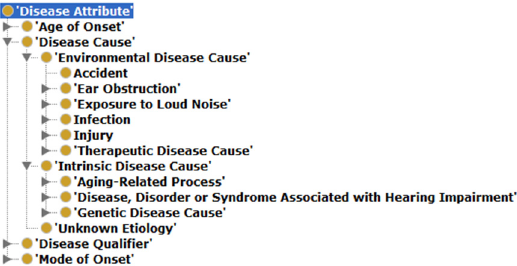
Figure 5. The ‘Disease Attribute’ class structure within the HIO. This hierarchy is intended to contain all possible features specific to or leading to HI.